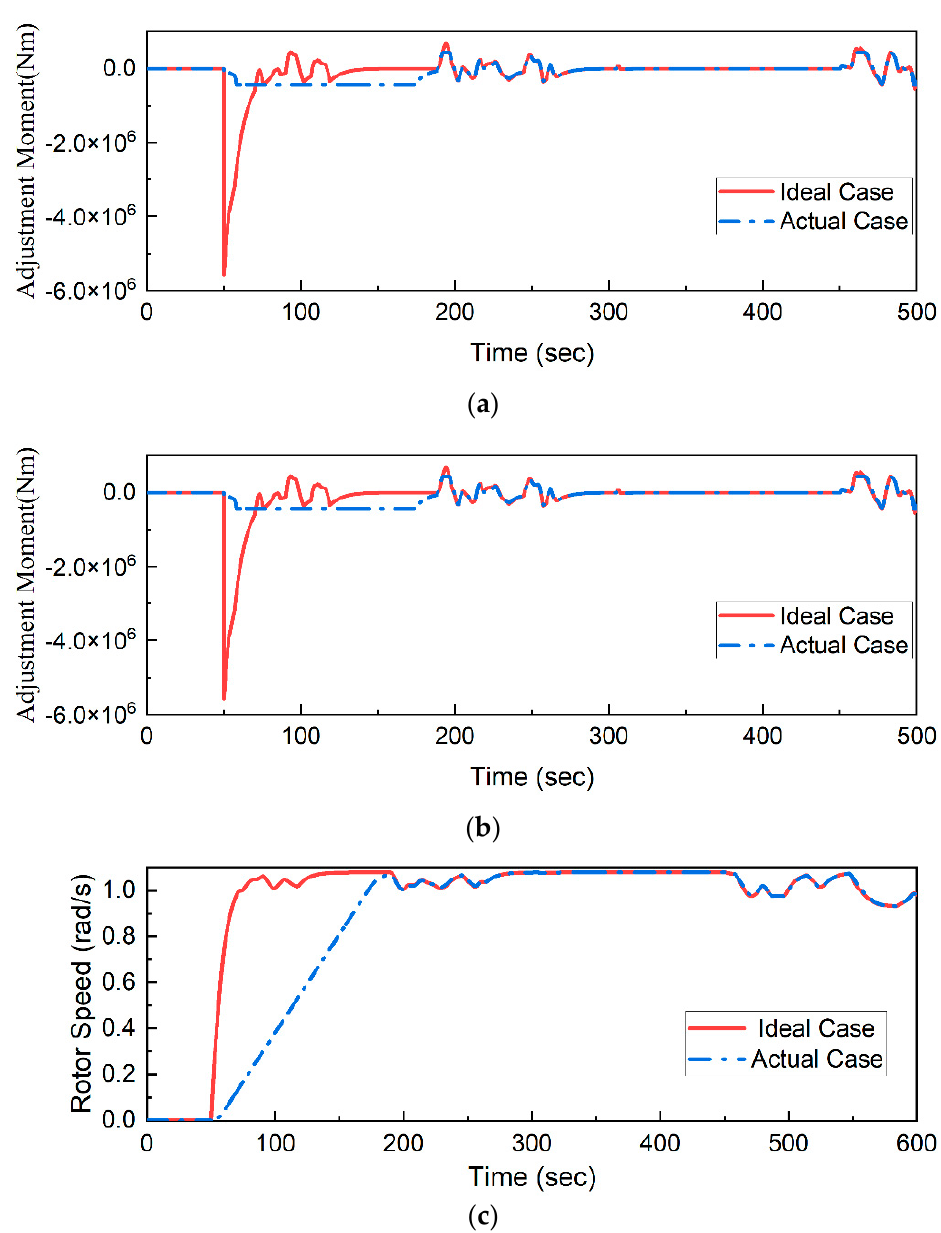
Figure 9. Wind turbine performance via different controlling strategies. ( a ) Adjustment moment; ( b ) Rotor speed; ( c ) output power.